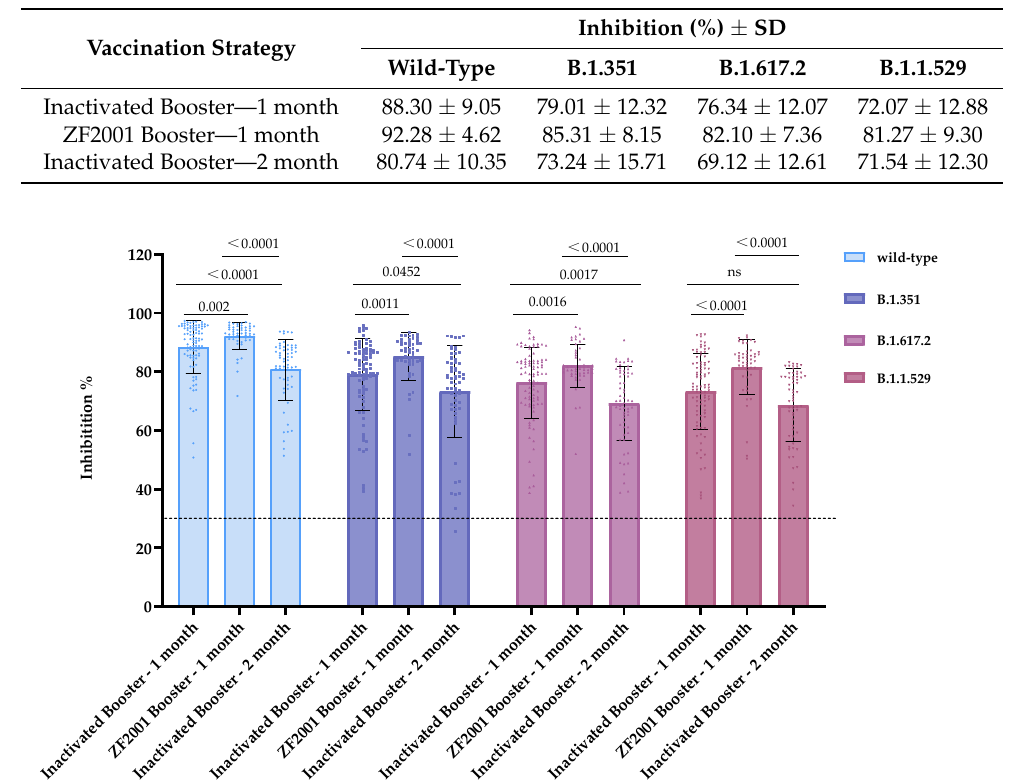
Table 3. The post-booster average inhibition rates against wild-type, B.1.351, B.1.617.2 and B.1.1.529 mutant strains.